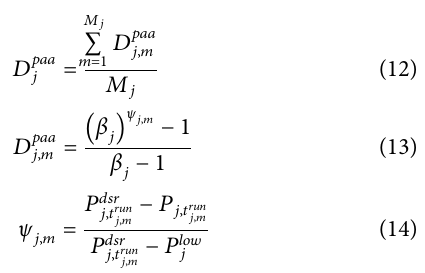
Frontiers in Energy Research |